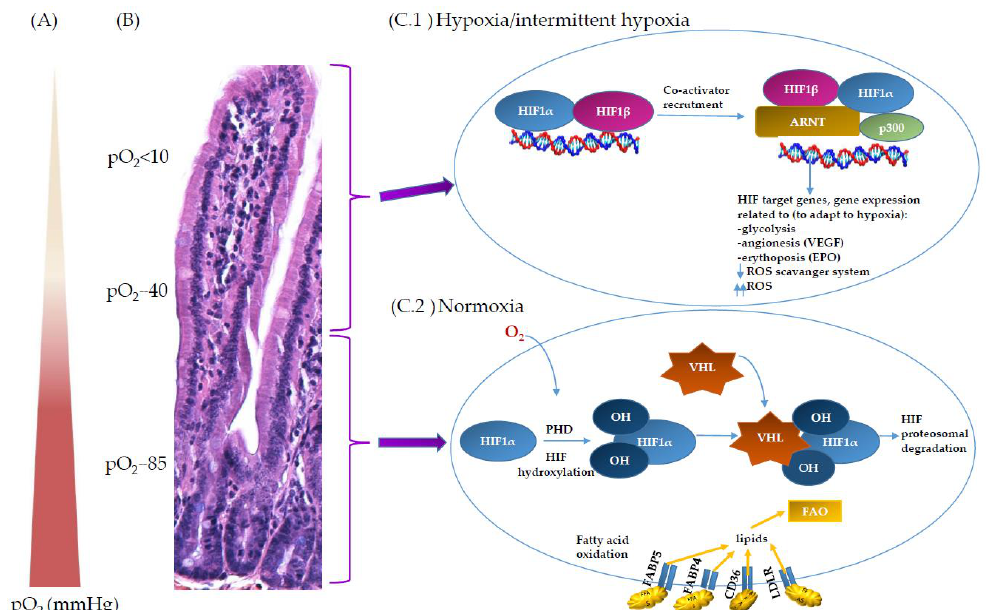
Figure 1. O 2 and its regulation at the intestinal epithelial barrier site. ( A ) Counter current blood flow reduces local pO 2 along the crypt–villus axis and results in low pO 2 at the villus tip. ( B ) Histological section of small intestine; villus–crypt axis, BALB/cOlaHsd mouse. ( C ) Hypoxic/normoxic environment along crypt–villus axis. ( C.1 ) Hypoxic condition or intermittent hypoxia at the upper part of the villa; inactive HIF hydroxylases. HIF-1 is composed of two subunits—oxygen- sensitive HIF-1 α and HIF-1 β . Due to low O 2 , PHD activity is decreased. HIF-1 α is stabilised and binds to ARNT in the presence of co-activator p300; altogether, it activates transcription factor of HIF target genes. ( C.2 ) Normoxic conditions at the bottom of the crypt. In the presence of O 2 , PHD enzyme hydroxylates the two proline residues on HIF, enabling the binding of VHL to the HIF subunit, which degrades HIF-1 α subunits under normoxic conditions. Fatty acid oxidation (FAO) is predominately present in normoxic cells.